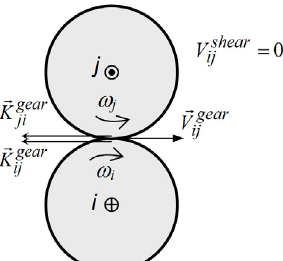
V = =  , q = q and tan g i j ij ji ij